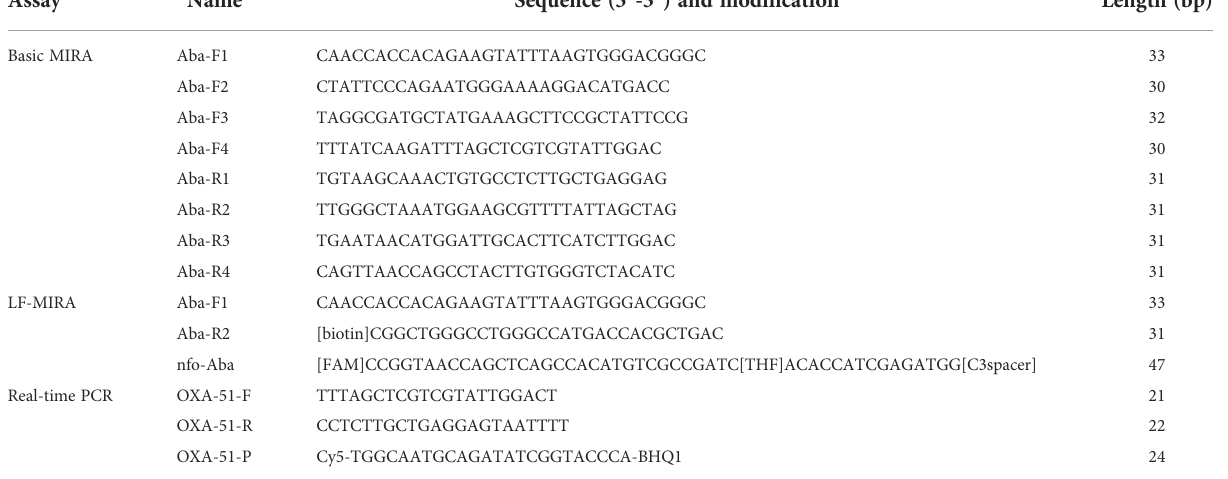
TABLE 1 Primers and probe used in the present study. Assay